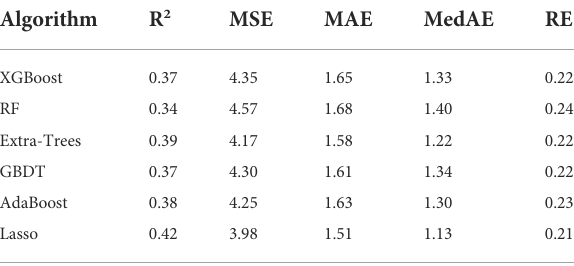
TABLE 4 Algorithm performance results (test